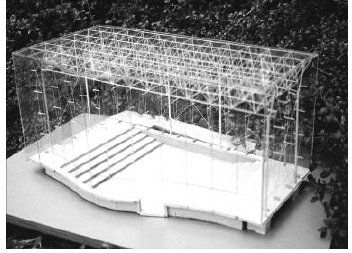
Figure 6 Model of Glass music hall,